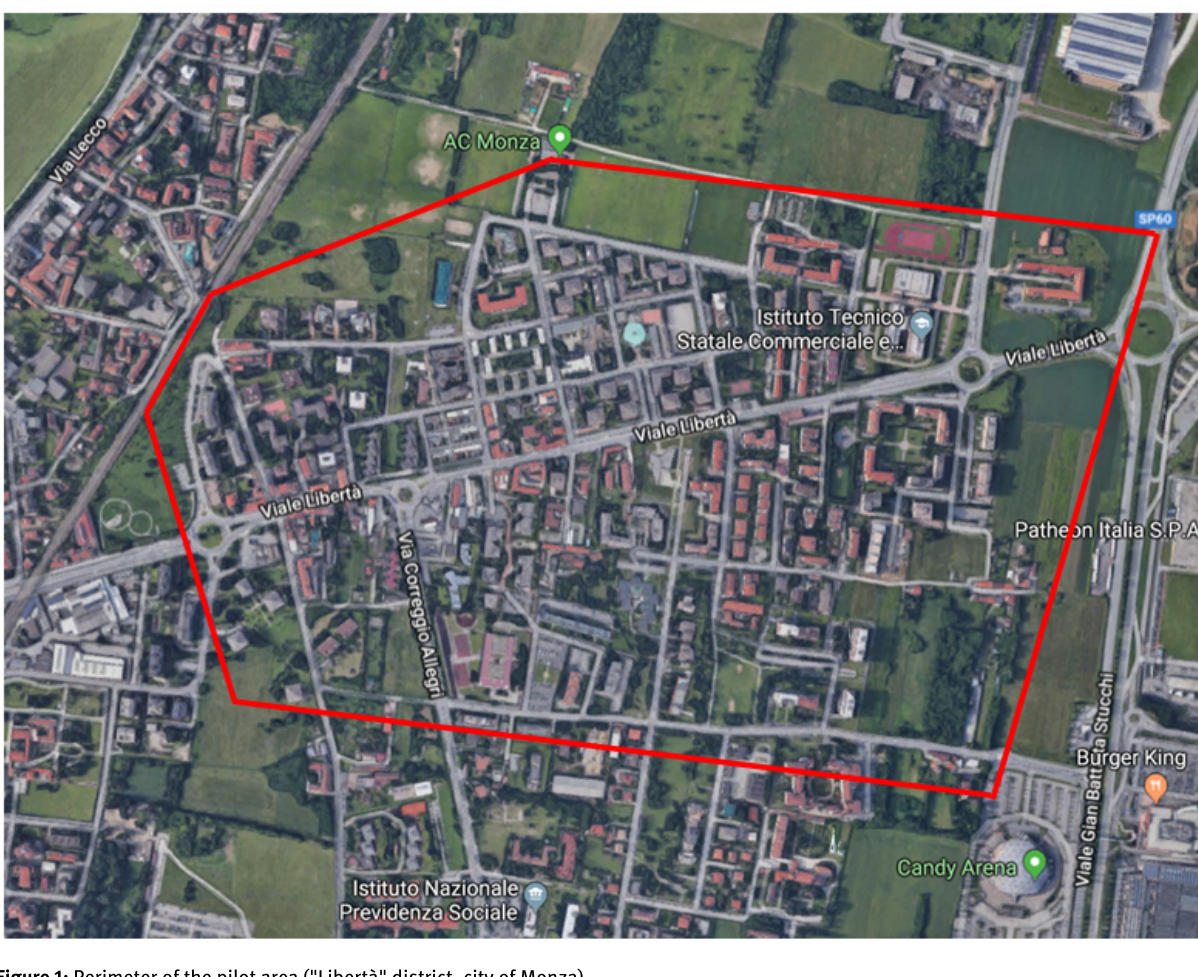
Figure 1: Perimeter of the pilot area ("Libertà" district, city of Monza)